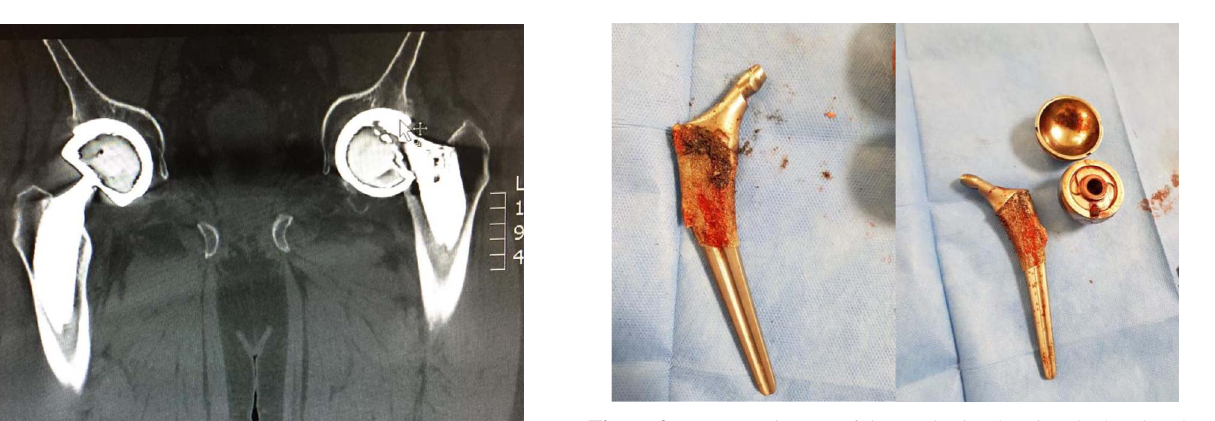
Figure 3. Intra-op pictures of the prothesis, showing the bend at the neck-taper junction.